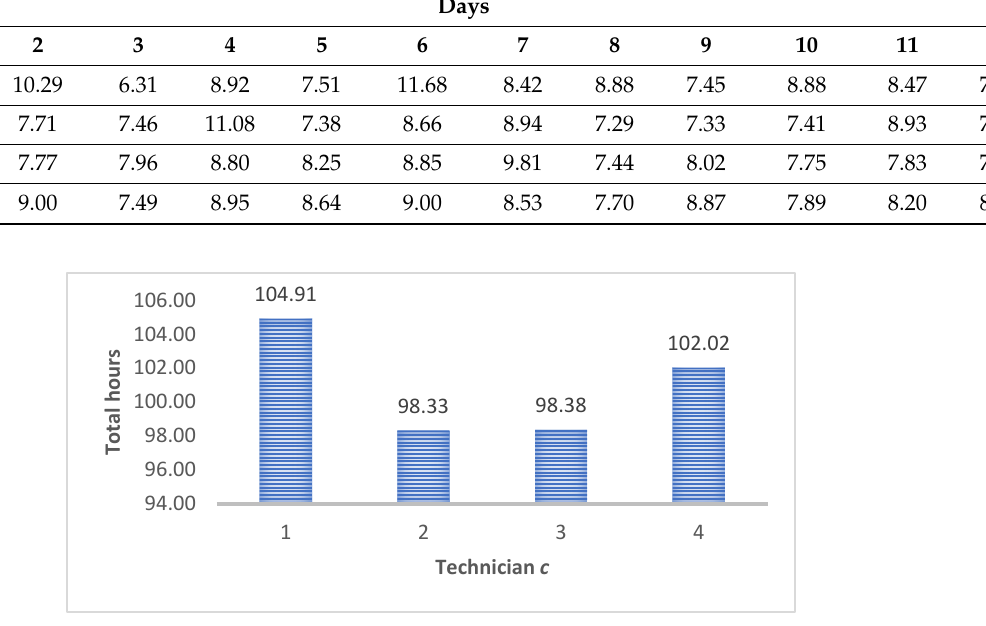
Figure 10. Total hours operated by each technician over 12 days. Table 8. The optimal schedule for tasks by technicians over 12 days.